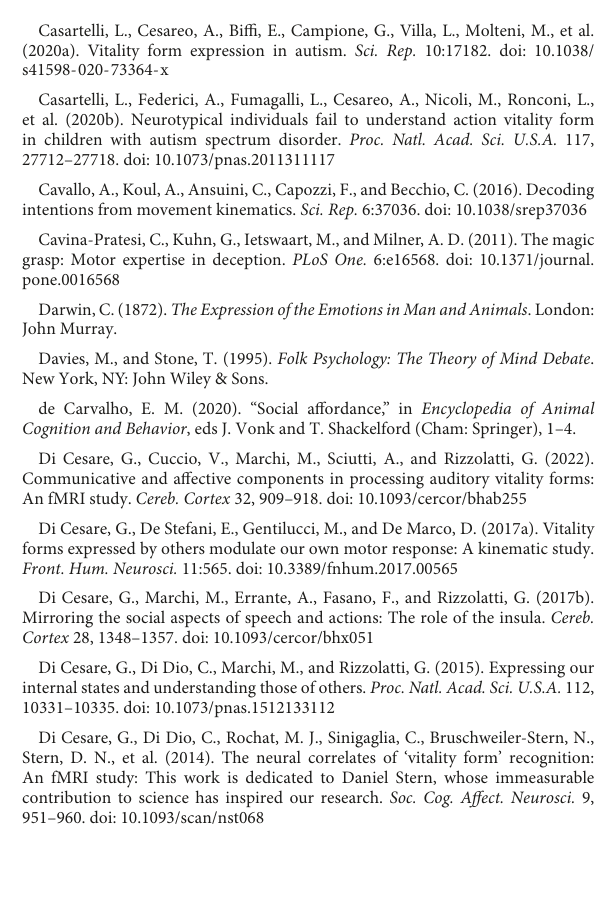
Figure 1 . Besides, the neural bases of vitality forms should be regarded as one part of the larger human MNS, since the former simply concerns the how-dimension of action rather than all dimensions involved in the social perception of dyadic